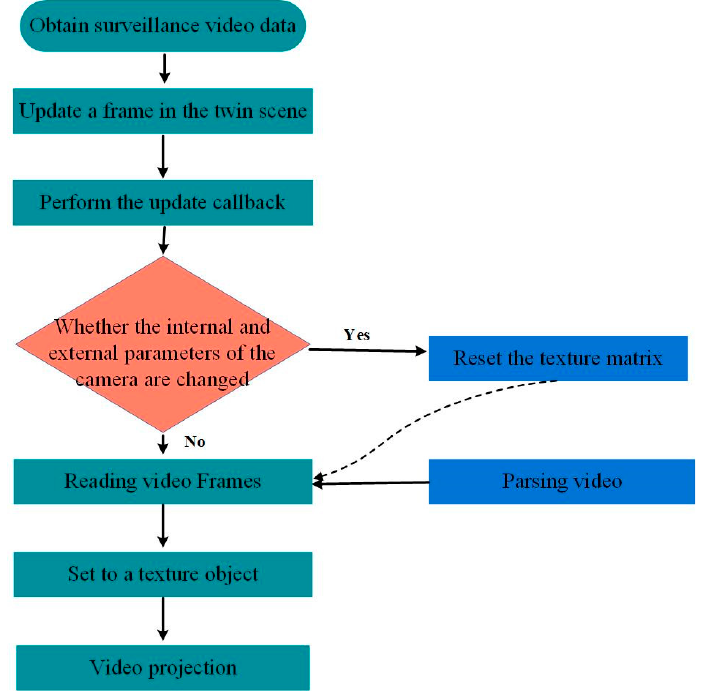
Figure 3. Flowchart of video image and digital twin scene fusion.